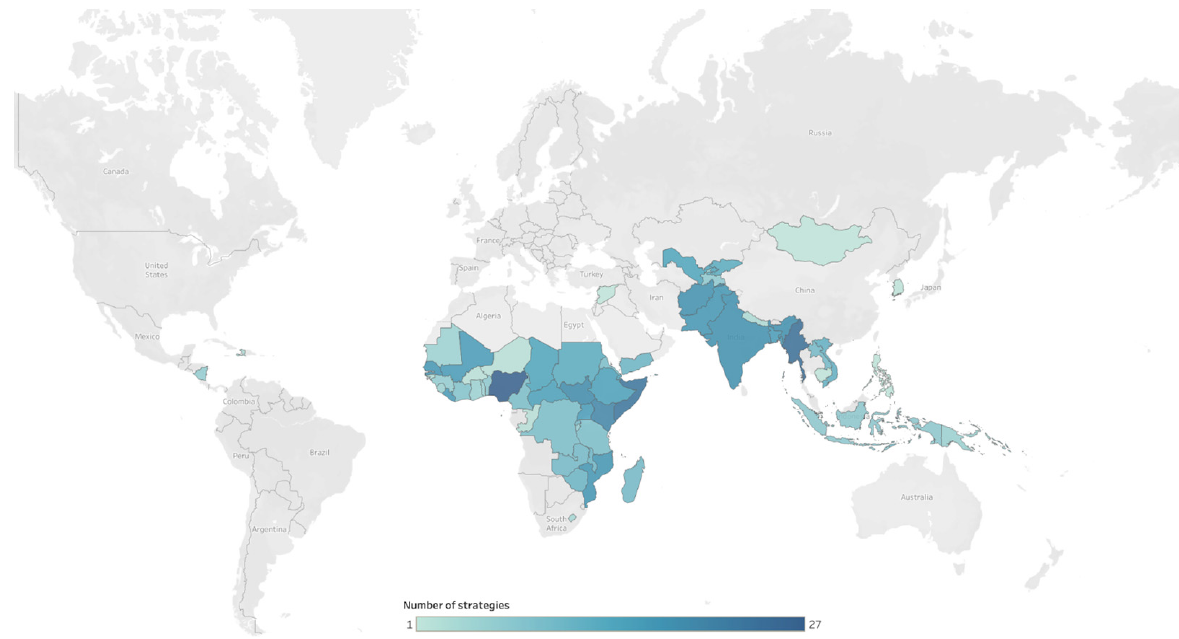
Figure 1. Number of strategies per country.